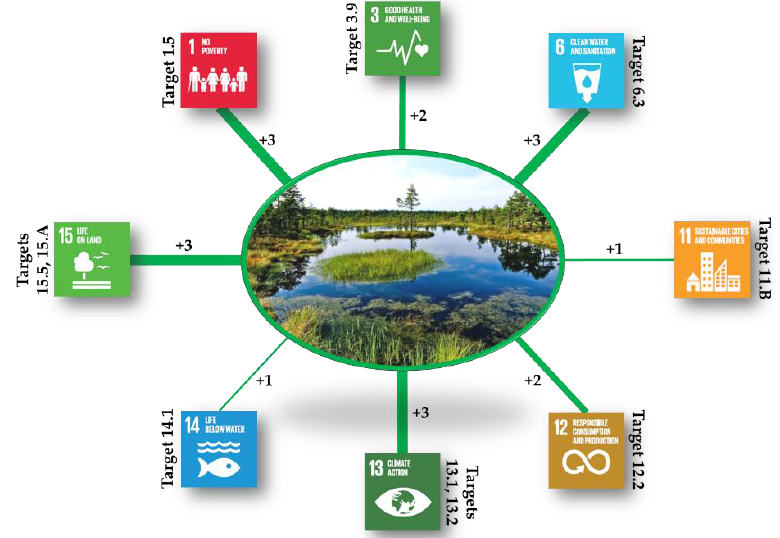
Figure 5. Positive water purification interactions identified between United Nations Sustainable Development Goals (SDGs) and Swedish wetland ecosystem services. Photo by Dmitri Korobtsov.